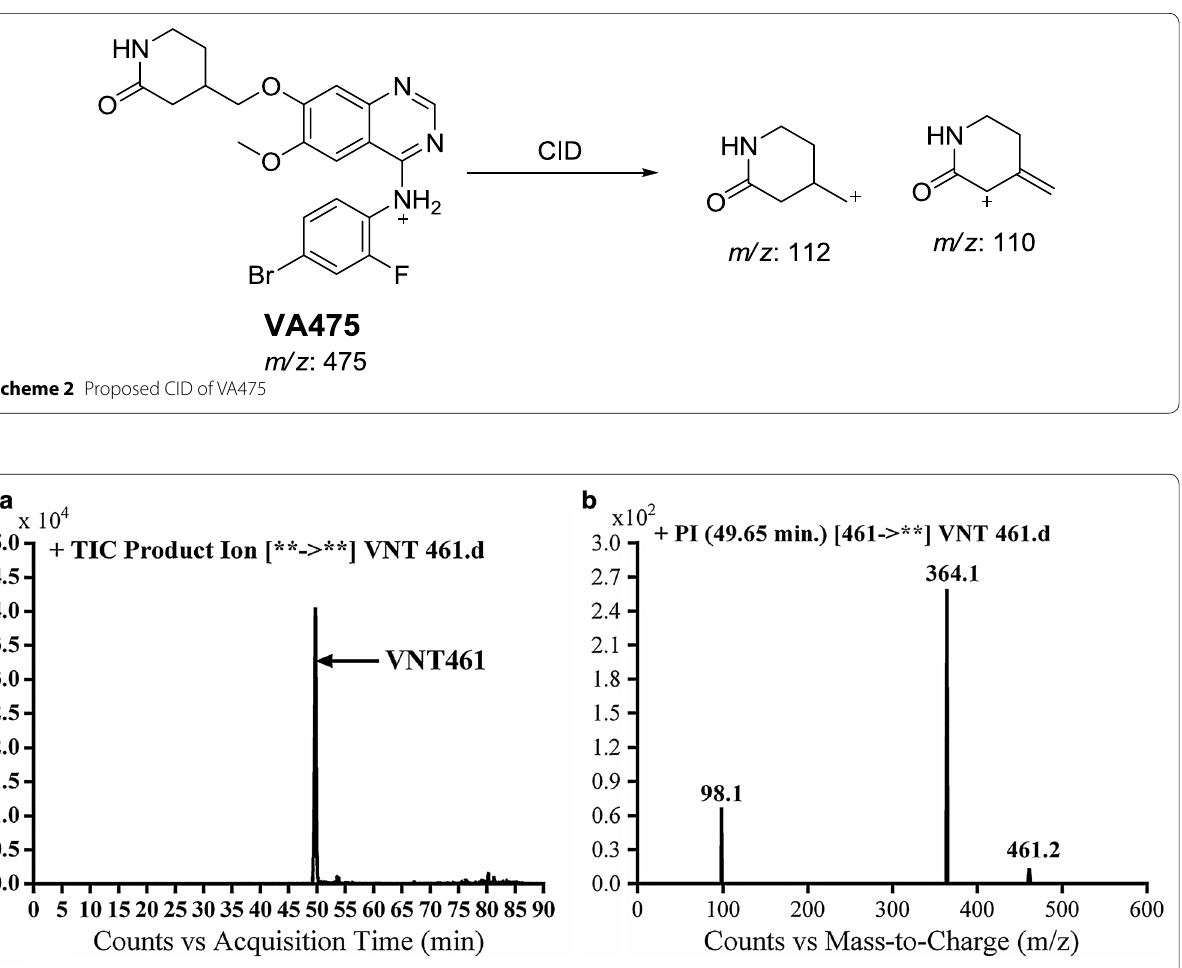
Fig. 2 EIC of MIP at m/z 461 showing one peak (VA461) at 49.7 min ( a ) and PI mass spectrum of VA461 at m/z 461 ( b